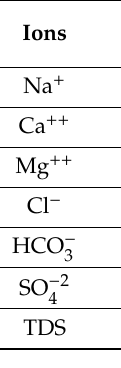
Table 1. The composition of the synthetic seawater